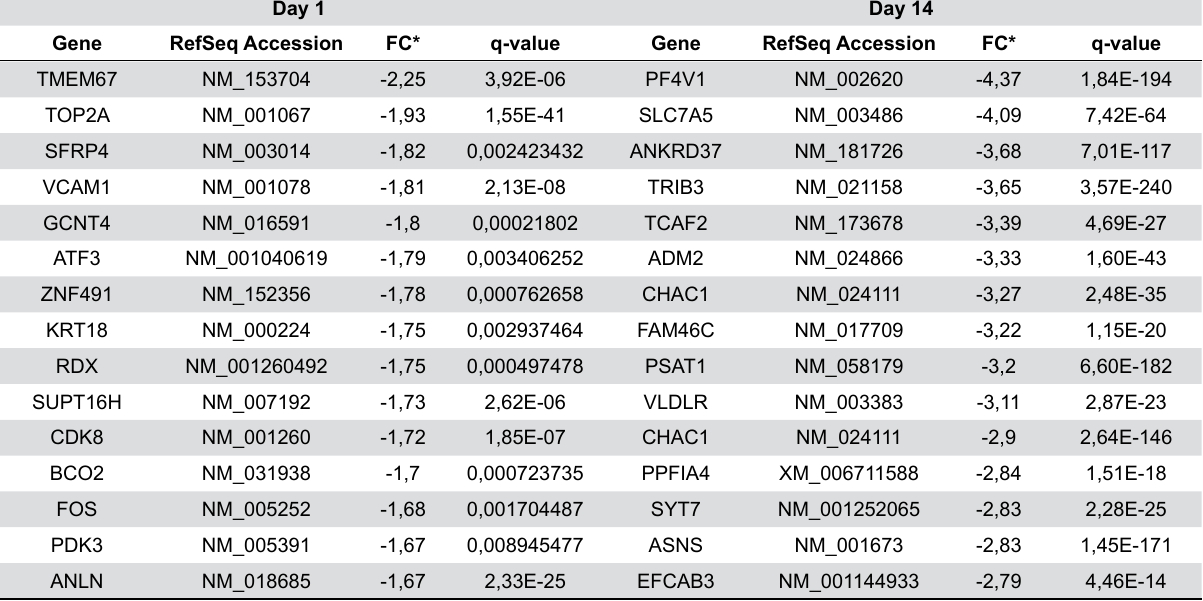
Table 2- Top 15 most down-regulated genes under high glucose